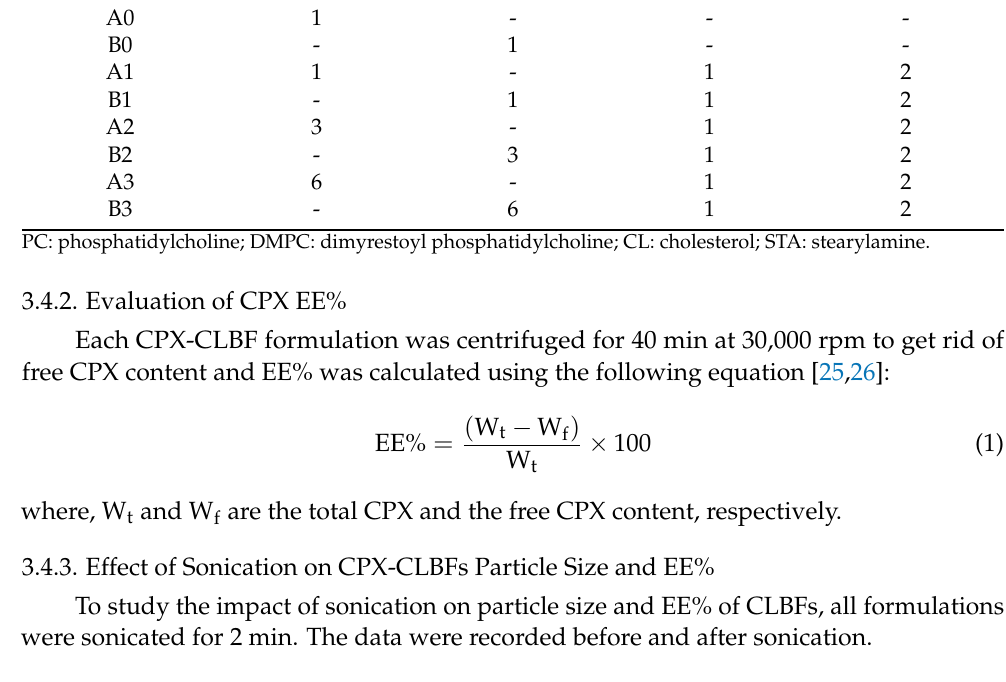
Table 3. Composition of ophthalmic CPX-CLBFs in molar ratios.